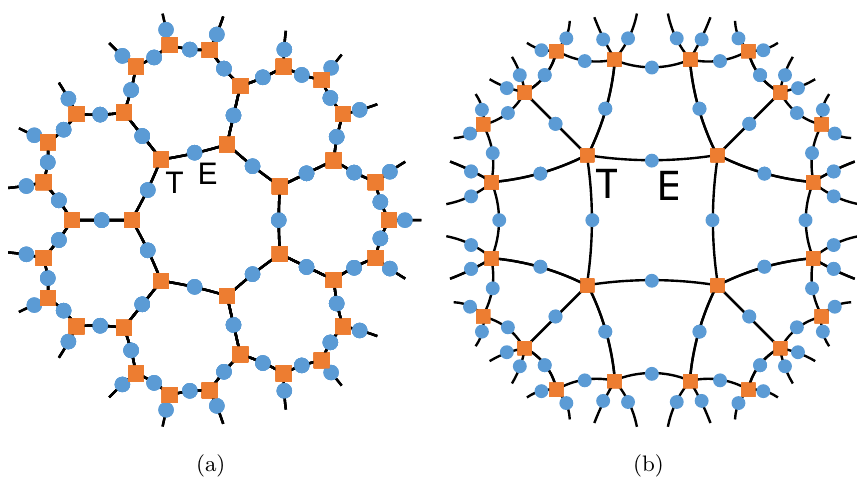
Figure 1 . Two tensor networks with (a) f 7 ; 3 g tiling and (b) f 4 ; 5 g tiling, where a tensor T is marked by an orange square while a tensor E is marked by a blue dot. Only (cid:12)nite layers are plotted. For convenience, all the tensors T and E will not be manifestly displayed in the latter (cid:12)gures of tensor network except